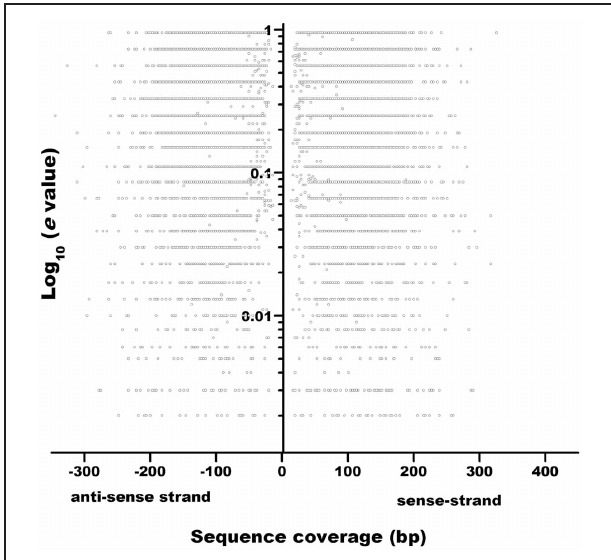
FIGURE 1 | Sequence similarity of 3 (cid:2) -non-coding sequences of putative P. vulgaris sORFs to the Arabidopsis thaliana protein collection. 1kb non-coding sequences (sense- and anti-sense strands) downstream stop codons of putative P. vulgaris sORFs are plotted as a function of similarity to A. thaliana proteins ( e - 10 value).